Question: What visual encoding does this figure use to show its data?
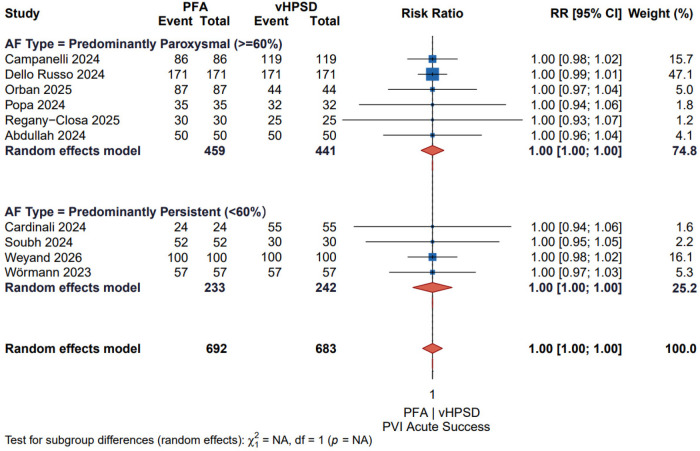
Answer: forest